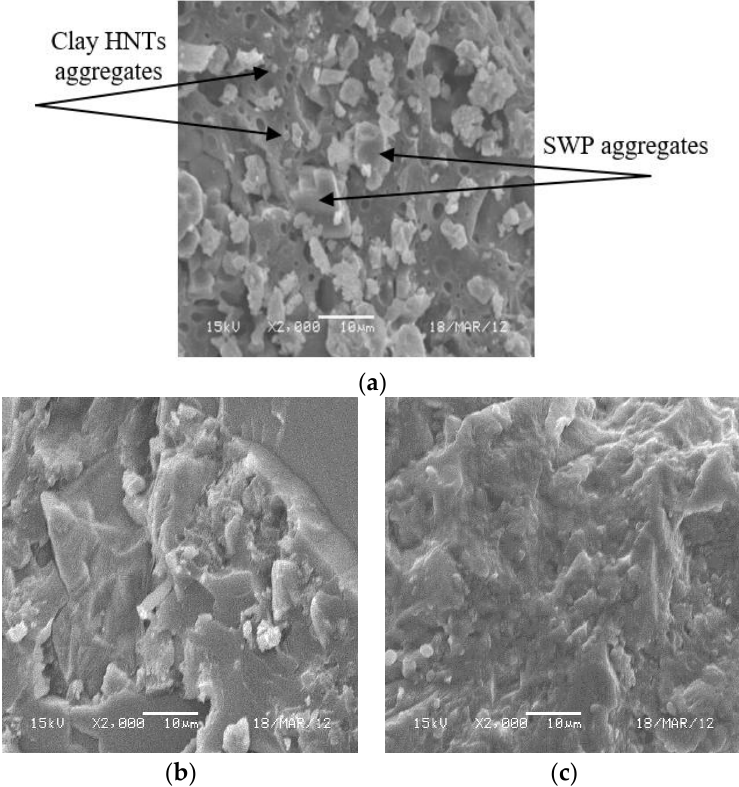
Figure 3. SEM micrographs of Granite/PMMA/clay HNTs nanocomposites impregnated with different SSF concentrations ( a ) 10 wt %, ( b ) 60 wt % compared to ( c ) natural granite.